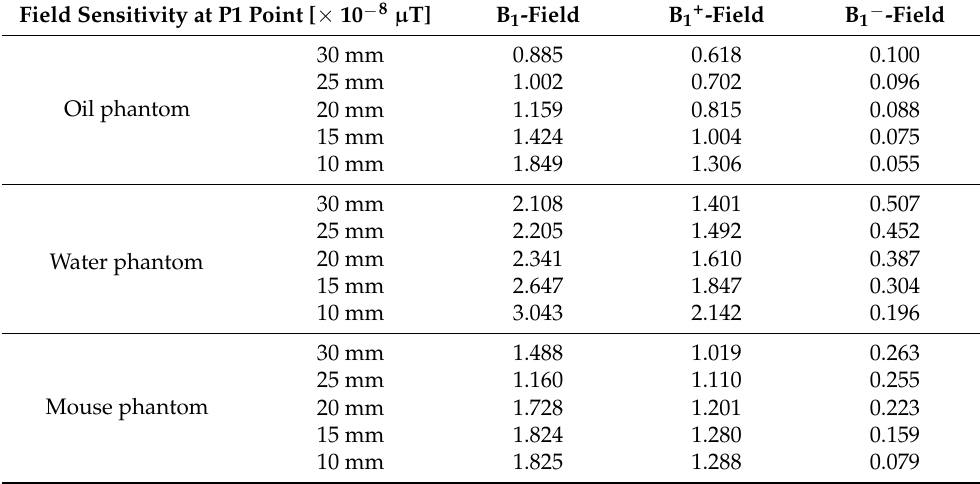
Table 2. Field sensitivity at P1 point according to the change in size of single-channel surface RF coils using oil phantom, water phantom, and mouse phantom.